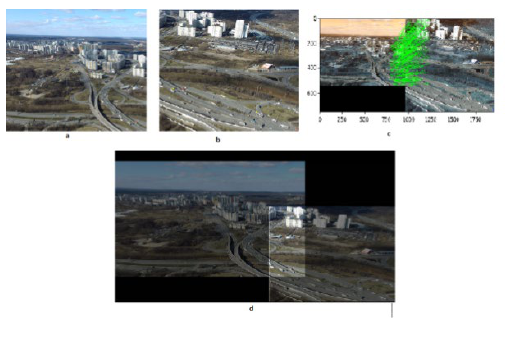
Figure 7. Final Resultant Fused Image (R esult-1 )